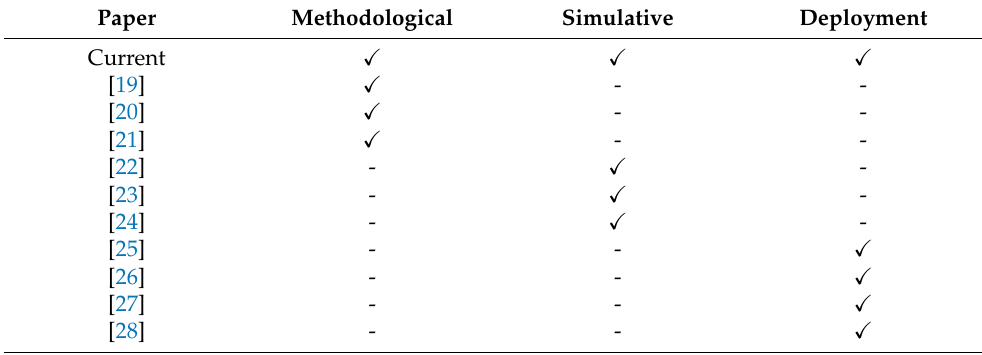
Table 1. Comparison of the reported related